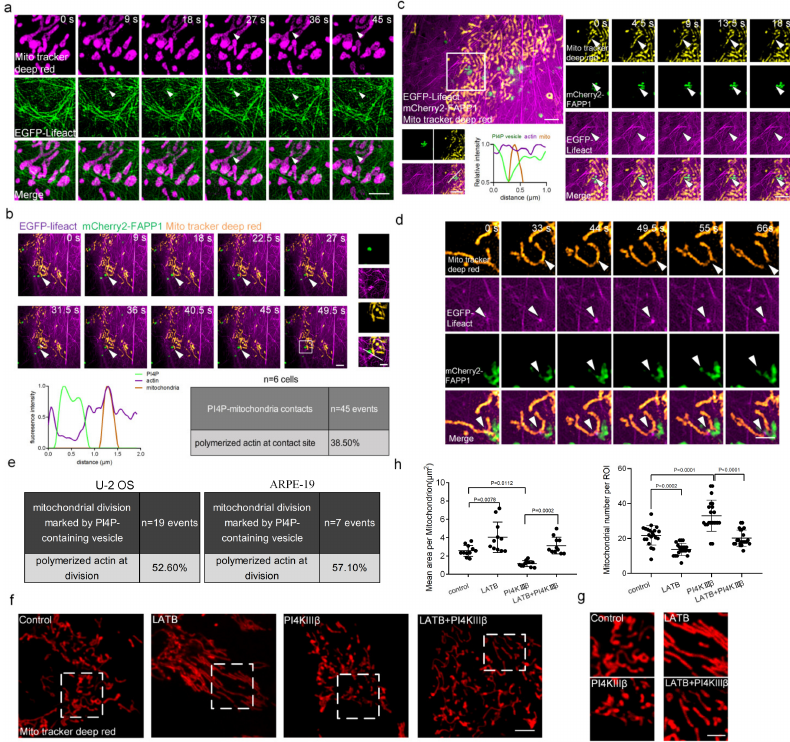
Figure 4. PI4P-containing vesicles participate in mitochondrial division by coordinating polymerized actin. ( a ) Representative SIM images of actin filaments (tagged with EGFP-Lifeact, green) and mitochondria (stained with MitoTracker Deep Red, magenta), showing that actin polymerized at the site of mitochondrial division. Scale bar: 2 µ m. ( b ) Long-term SIM images of PI4P-containing vesicles (tagged with mCherry2-FAPP1, green), actin filaments (tagged with EGFP-Lifeact, magenta) and mitochondria (stained with MitoTracker Deep Red, yellow) in live U-2 OS cells. Inserts show the area indicated by the white box with a PI4P vesicle–mitochondrion contact marked by the actin polymerization at a higher magnification. Our criterion for identifying a three-way contact was the presence of actin at a PI4P vesicle–mitochondrion contact site for at least 10 s. Line-scan analysis of relative fluorescence intensities from the white line in the merge is shown. Percentage of PI4P vesicle–mitochondrion contacts marked by the actin polymerization in 15 cells. Scale bar: 2 µ m and 1 µ m (insert). ( c ) Representative SIM images of PI4P-containing vesicles (tagged with mCherry2- FAPP1, green), actin filaments (tagged with EGFP-Lifeact, magenta), and mitochondria (stained with MitoTracker Deep Red, yellow) in live U-2 OS cells, showing PI4P-containing vesicles and actin polymerization at the site of mitochondrial division; the right panel displays long-term images in the white box, with a line-scan analysis of relative fluorescence intensities from the white line in the merged image shown. Scale bar: 2 µ m, 1 µ m. ( d ) Representative SIM images of PI4P-containing vesicles, actin filaments, and mitochondria in live ARPE-19 cells. Scale bar: 1 µ m. ( e ) Percentage of PI4P-containing vesicles marked wth mitochondrial division events that were also marked by polymerization actin in 25 U-2 OS cells (left) and in 5 ARPE-19 cells (right). ( f ) Representative images showing mitochondrial morphology in U-2 OS cells treated with LatB or PI4KIII β or both LatB and PI4KIII β or DMSO. Scale bar: 5 µ m. ( g ) Four areas from f were shown at enlarged sizes, scale bar: 2 µ m. ( h ) Quantification of mitochondrial morphology based on the images presented in ( f ) to determine the mean area per mitochondria in 10 cells and mitochondrial number per ROI in 20 cells. Cells from three independent experiments. All graphs show the mean ± SEM. Statistical significance: p < 0.05; p < 0.01; p < 0.001; p <